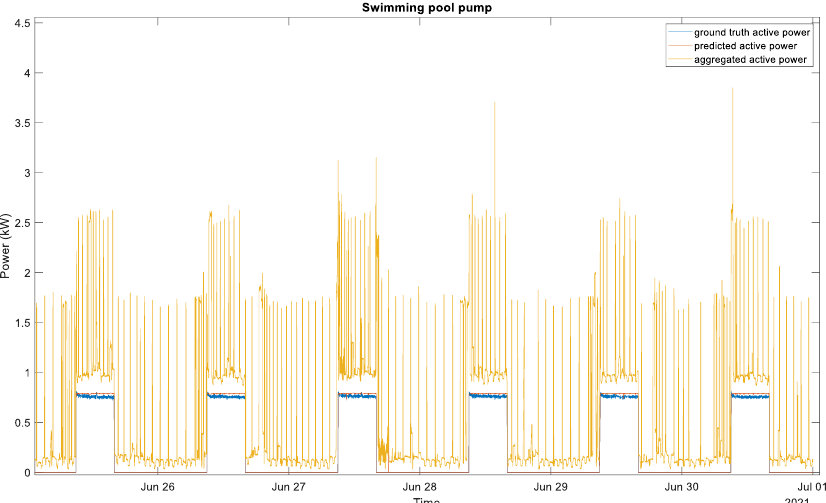
Figure 8. Disaggregation output of the electric water heater. Blue, ground truth active power; red, predictive active power; yellow, aggregate active power.